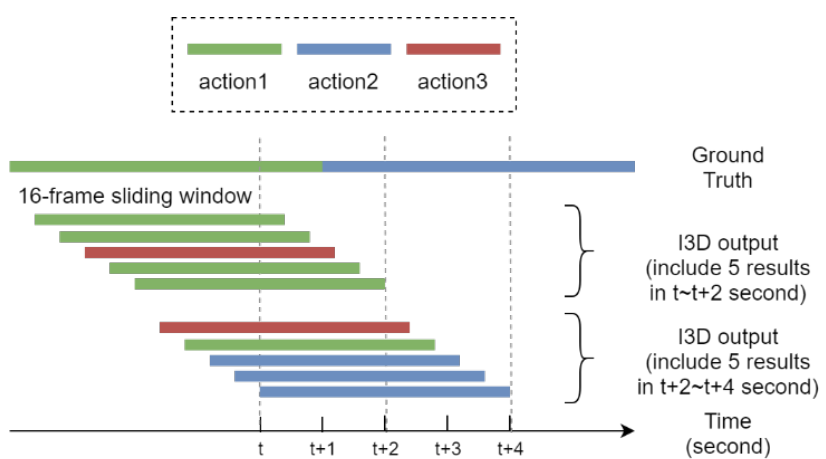
Figure 5. The proposed sliding windows method for action recognition, where from top to bottom shows the ground truth of actions and overlapped sliding windows each consisting of 16 frames.